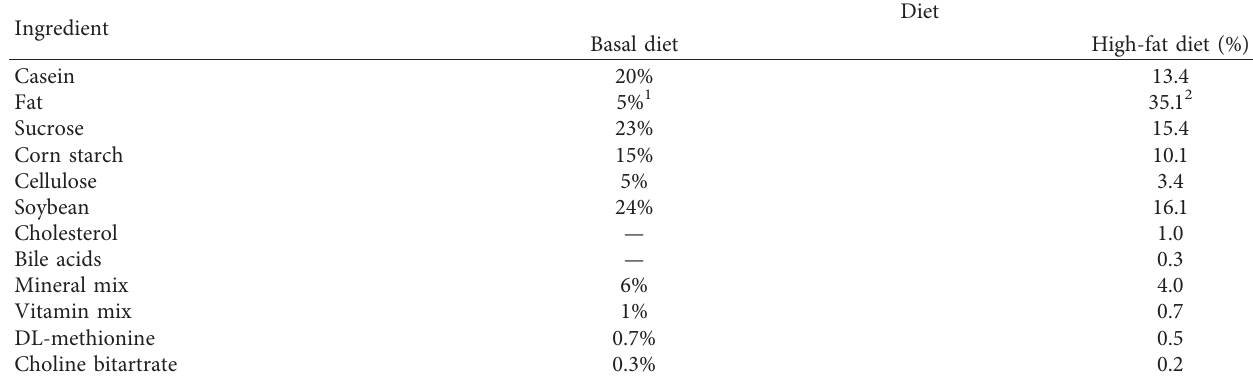
Table 1: Effect of the high-fat diet compared to the basal diet on body weight gain and metabolic parameters in male albino rats.